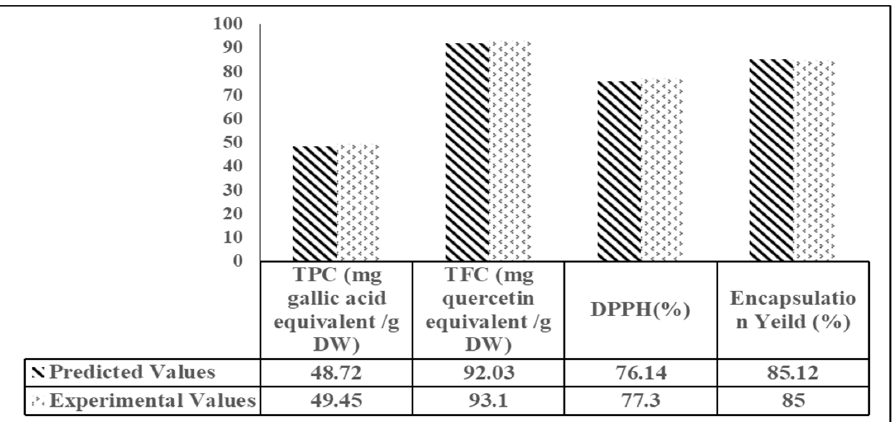
Figure 4. Predicted and experimental results used in the validation of model based on optimum formulations Sodium caseinate (SC) = 47.58%, Pectin (P) = 10.00%, and whey protein isolate (WPI) = 42.42%.